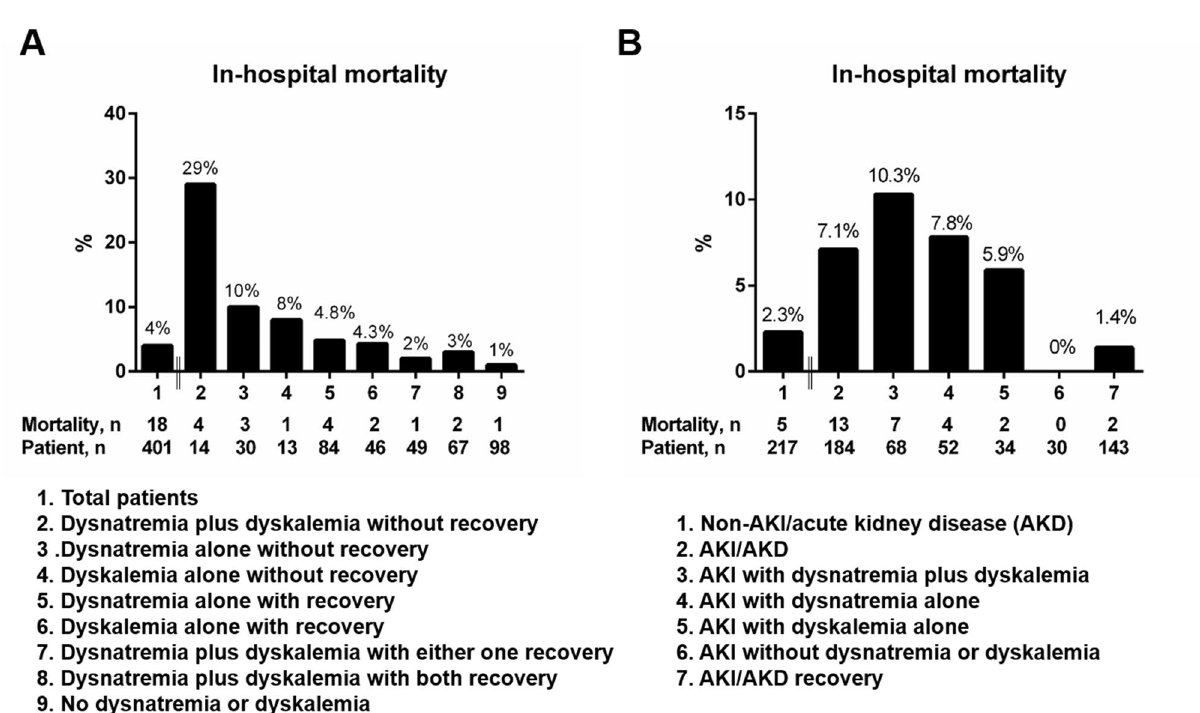
Figure 2. The percentages of in-hospital mortality in subgroups of patients with or without (A) development and resolution of electrolyte imbalances, and (B) development and recovery of AKI/acute kidney disease (AKD) in combination with electrolyte disorders. Figures were created using the GraphPad Prism software (version